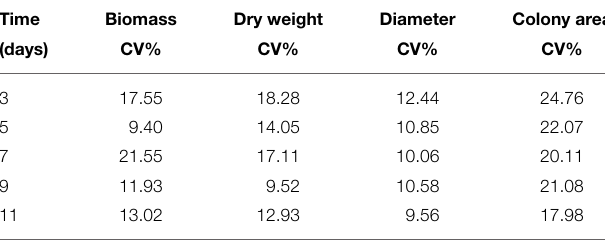
TABLE 2 | Coefficients of variation (CV%) of growth responses along time. TABLE 3 | OTA dispersion and CV% values.